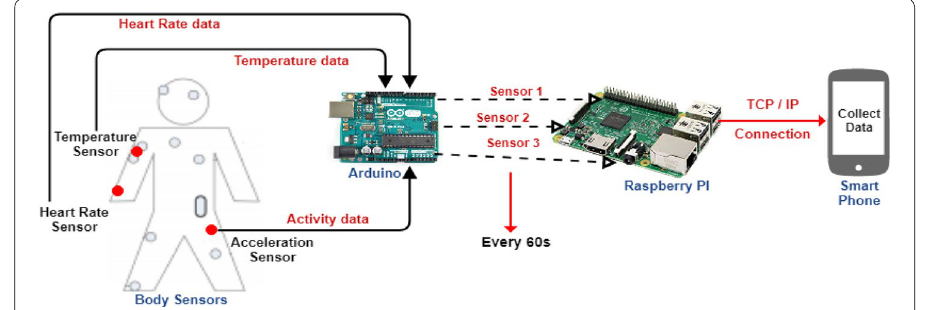
Fig. 3 Gathering sensors data